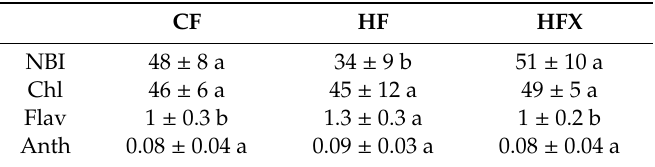
Figure 3. Fresh weight of leaves, stem and roots of pepper plants fertigated with nutrient solutions made with conventional fertilization (CF), MCT ® fertilizers (HF) and MCT ® fertilizers plus TX (HFX). Data are represented as the mean ± standard deviation. Di ff erent letters indicate significant di ff erences between treatments ( p < 0.05, n = 3). Table 3. Dualex indexes of nitrogen balance index (NBI), total chlorophylls (Chl), flavonols (Flav) and anthocyanins (Anth) measured in the fresh leaves of pepper plants fertigated with nutrient solutions made with conventional fertilization (CF), MCT ® fertilizers (HF) and MCT ® fertilizers plus TX (HFX). Data are represented as the mean ± standard deviation. Di ff erent letters indicate significant di ff erences between treatments ( p < 0.05, n =